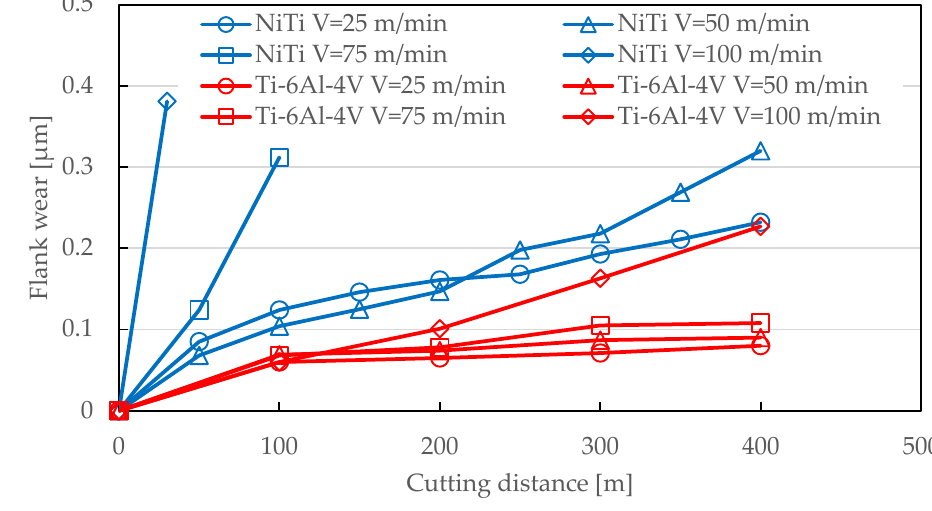
Figure 6. Relationship between the cutting speed and flank wear.